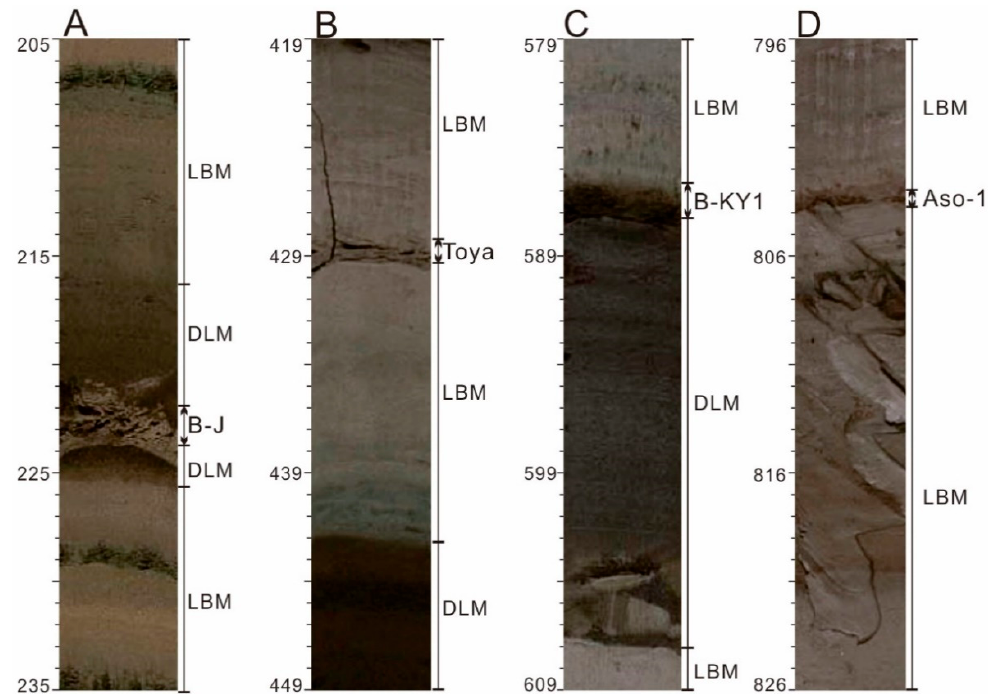
Figure 4. Photographs of tephra layers recovered from ODP 794A core in the Japan Basin of the East Sea/Japan Sea. ( A ): B-J, ( B ): Toya, ( C ): B-KY1, and ( D ) Aso-1 (Photographs adapted from [41]). The SiO 2 content ranged from 78.25 to 79.10 wt.% and total alkali content (Na 2 O + K 2 O) ranged from 5.35 to 7.17 wt.% (Table 2). Toya tephra plotted within sub-alkali rhyolite in the total alkalis versus silica (TAS, [42]) diagram (Figure 6). FeO* content was < 1 wt.% (0.72–0.95 wt.%). The CaO content was low (0.28–0.60 wt.%) (Table 2).